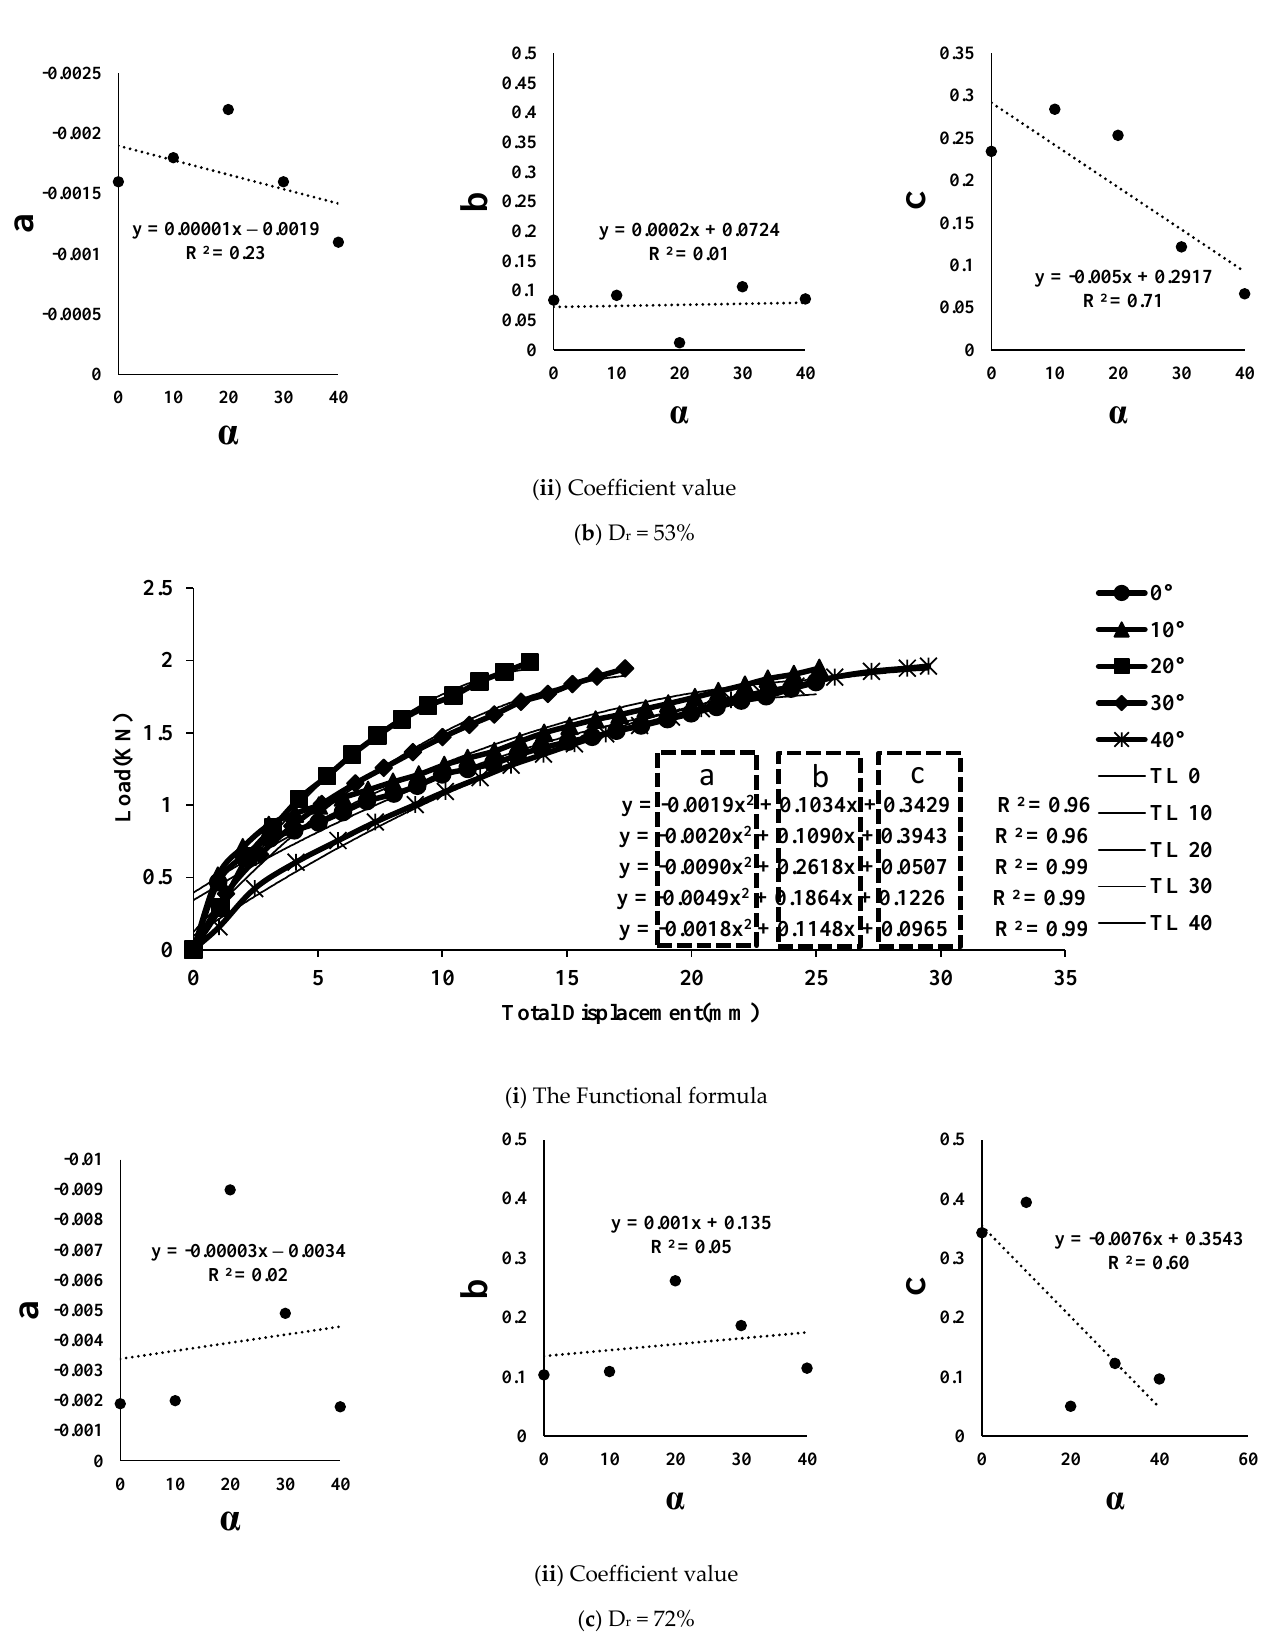
Figure 11. Experimental formularization by total displacement. In Figure 11i, y = ax 2 + bx + c is used to represent a quadratic function, and the values of the a, b, and c coefficients in the trend lines can be represented as a linear function in